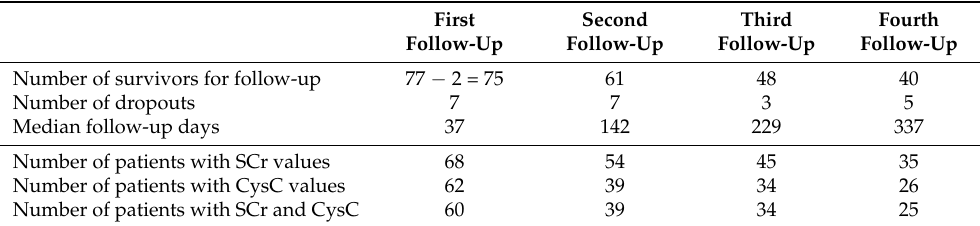
Table 2. Patients’ follow-up information after hospital